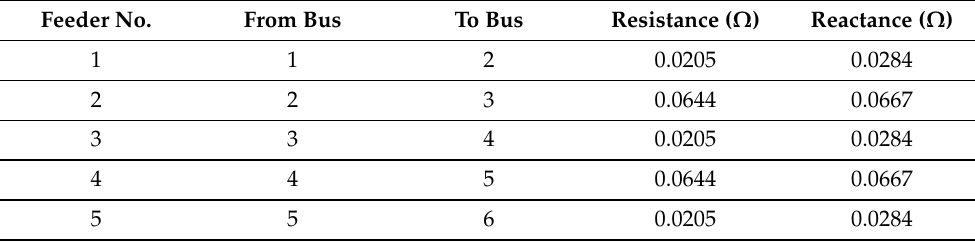
Table 1. Parameters of feeders.